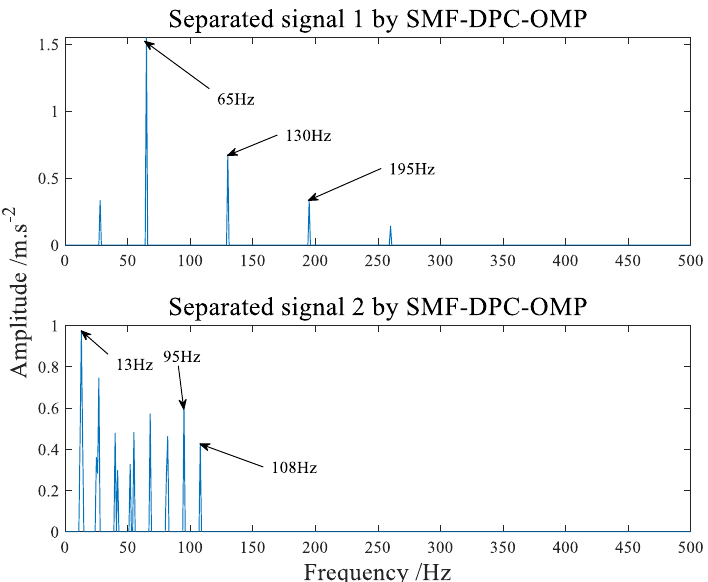
Figure 15. The frequency domain spectrum of separated signal processed by SMF − DPC − OMP.